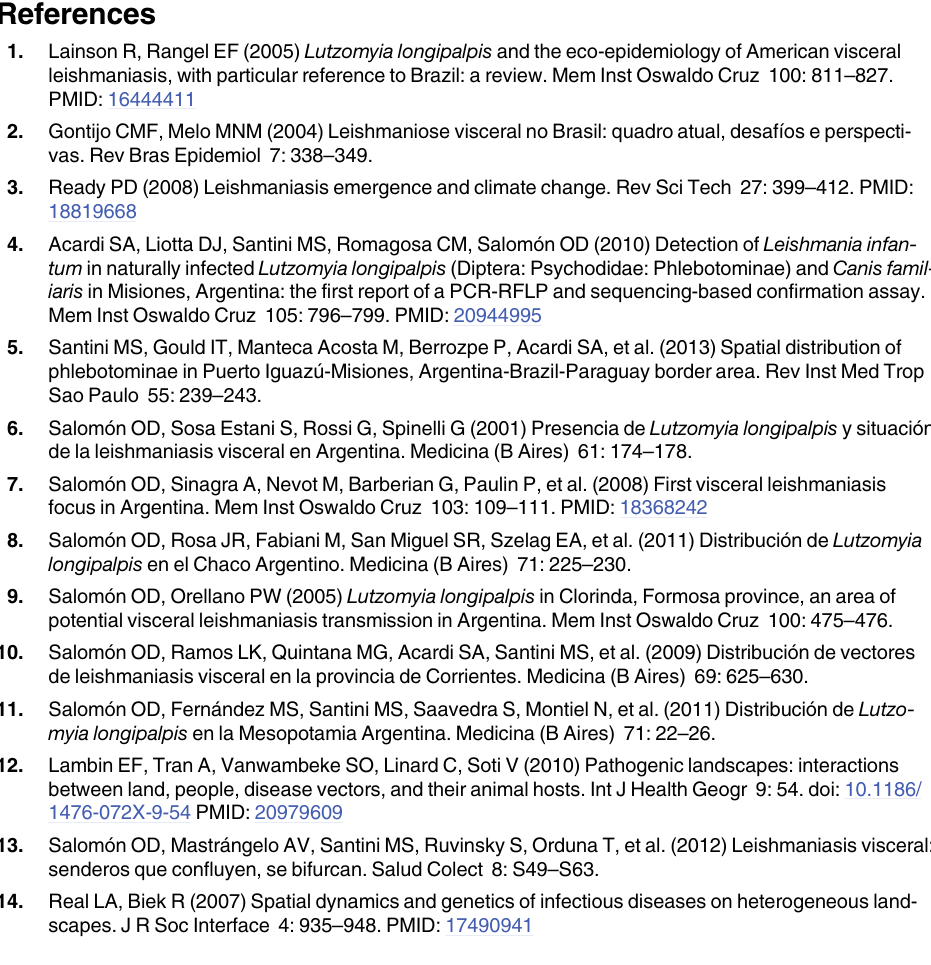
S1 Fig. Probability of sandfly presence. Estimated probability of sandfly presence (dots and smoothed line) in terms of increasing proportion of vegetation cover (Low + Medium/High density vegetation cover proportion). ID: